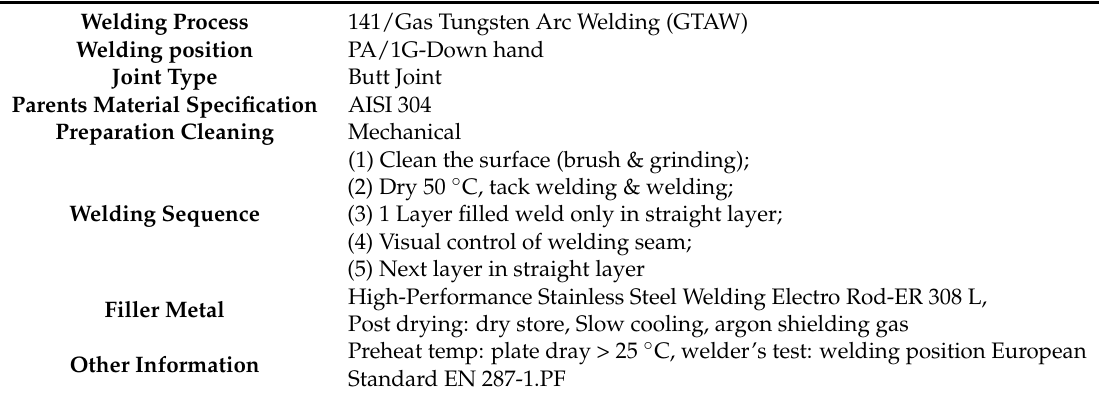
Table 2. Welding specification.